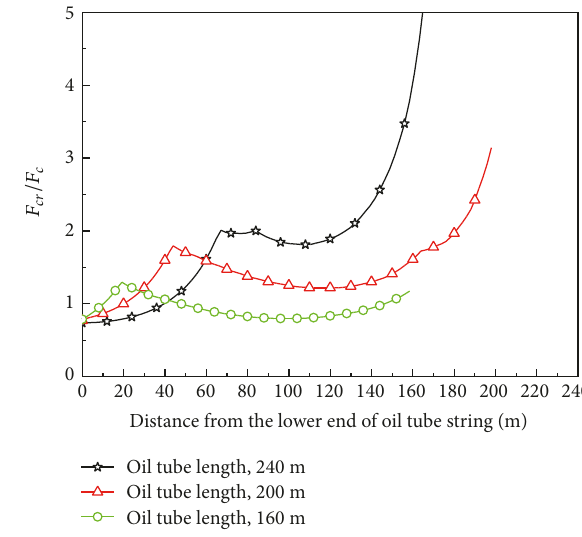
Figure 16: Effect of shock absorber on the buckling mechanical behavior oil tube string.